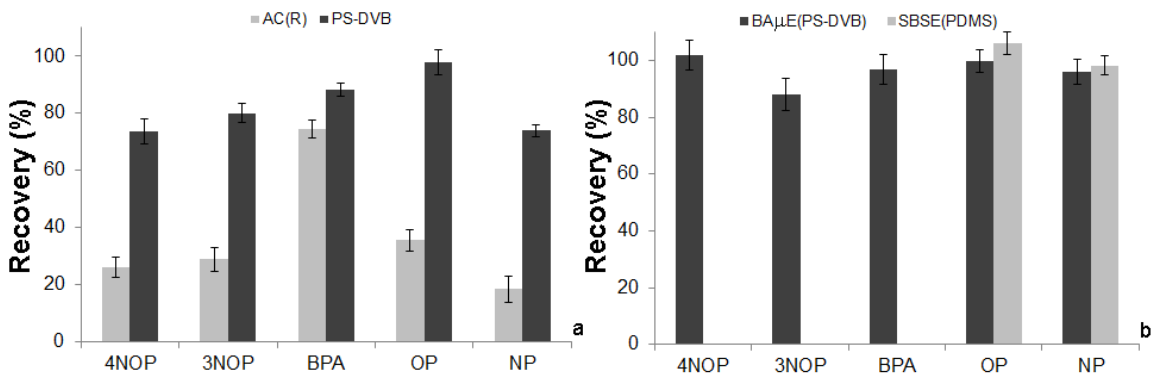
Figure 1. A Comparison of the recovery yields obtained by ( a ) BAµE using AC and PS-DVB as sorbent phases and ( b ) between BAµE (PS-DVB) and SBSE (PDMS) followed by LD/HPLC-DAD, under similar experimental